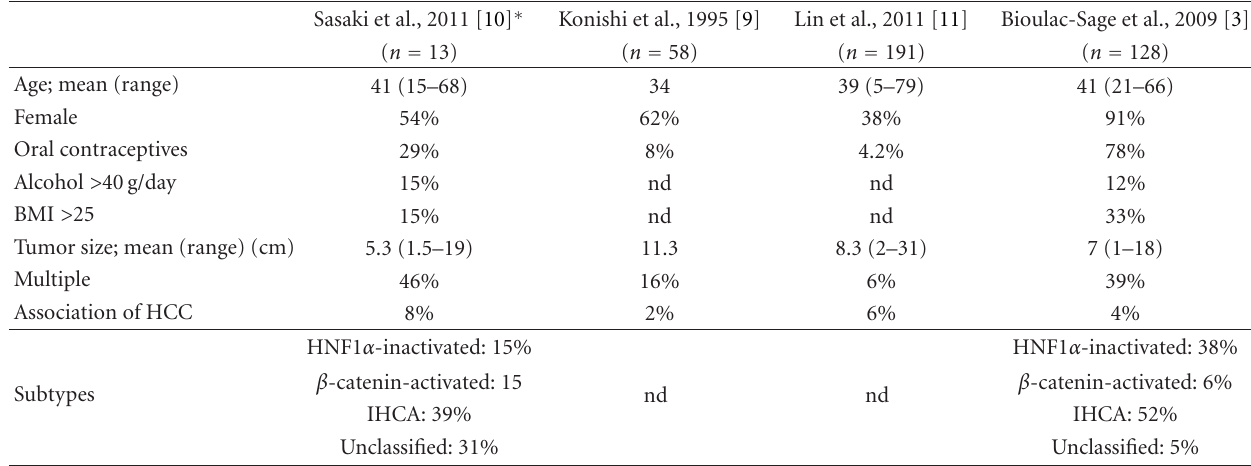
Table 2: Hepatocellular adenoma in Japan: a comparison with previous